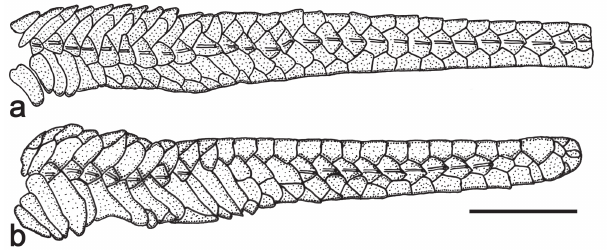
Fig. 2. Lateral plates of species of Microlepidogaster . a ) Microlepidogaster longicolla , MCP 23323; b ) M . perforatus , MCP 17717. Scale bar = 5